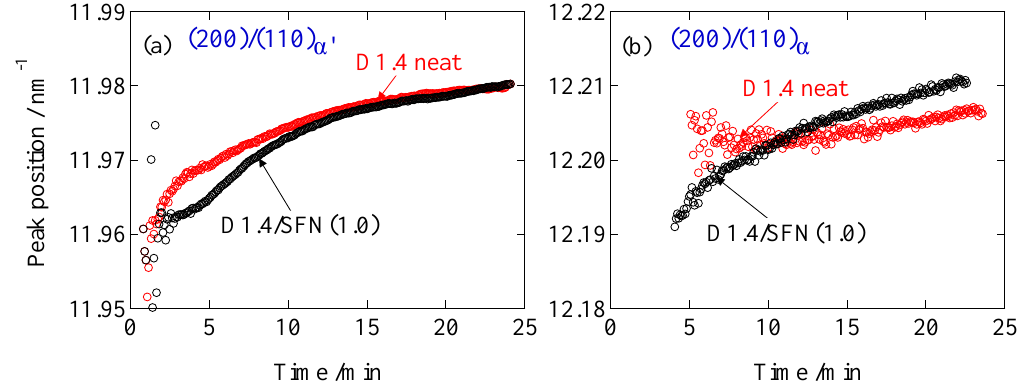
Figure 4. Changes in the position of the peak for ( a ) (200)/(110) α’ and ( b ) (200)/(110) α .